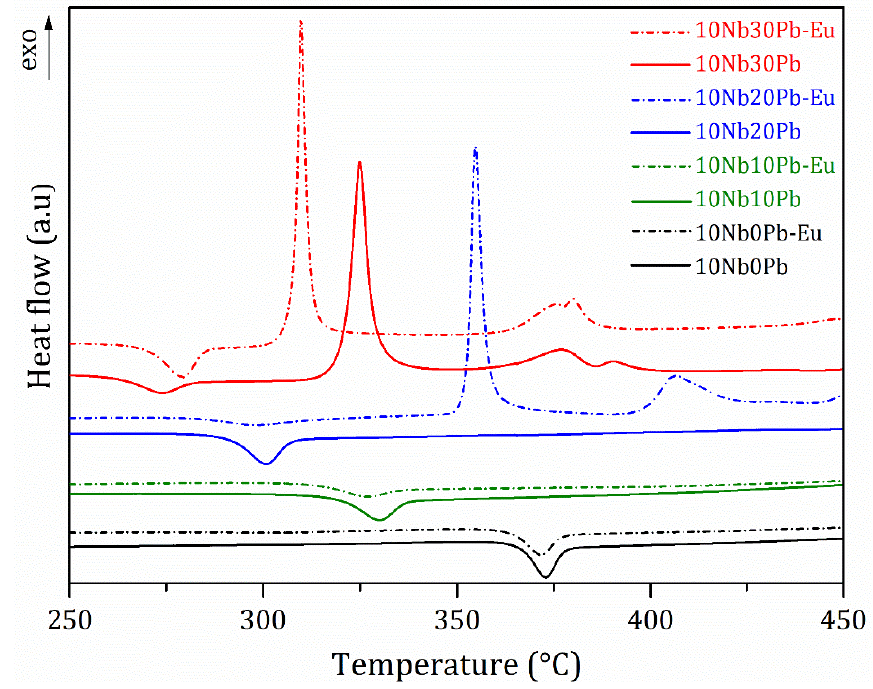
Figure 6. DSC curves of undoped and Eu 3+ -doped glass samples.